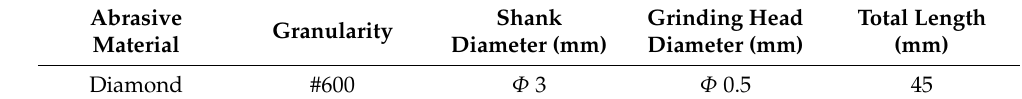
Figure 24. Structure diagram of micro-grinding rod.